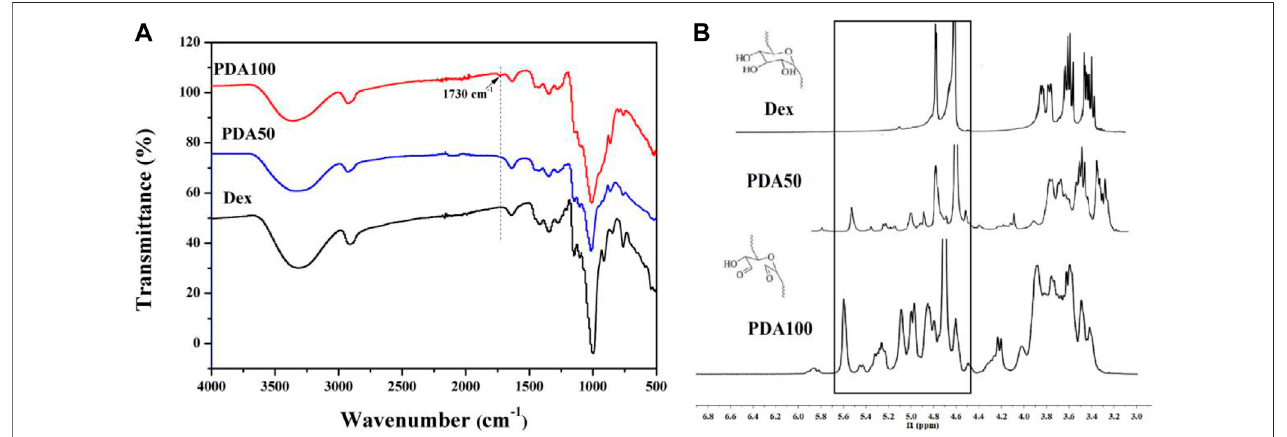
FIGURE 1 | (A) FT-IR spectrum Dex, PDA50, and PDA100; (B) 1H NMR spectrum of Dex, PDA50, and